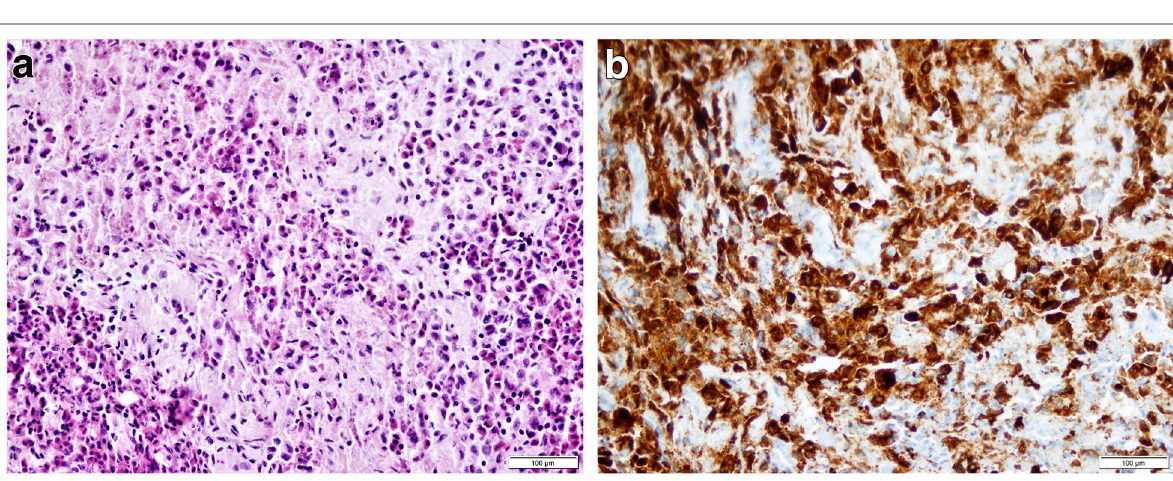
400). b Langerin positivity of Langerhans cells (Langerin, IHC; ×